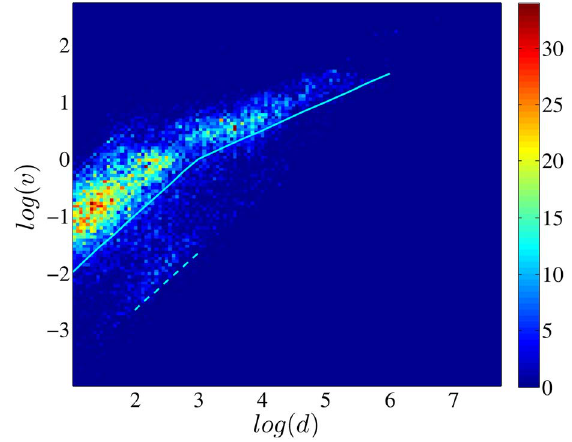
Figure 3. The relationship between the average speed v and the displacement d . The slopes of the upper lines are 1.0 and 0.5 respectively, whereas the slope of the lower dashed line is 1.0.